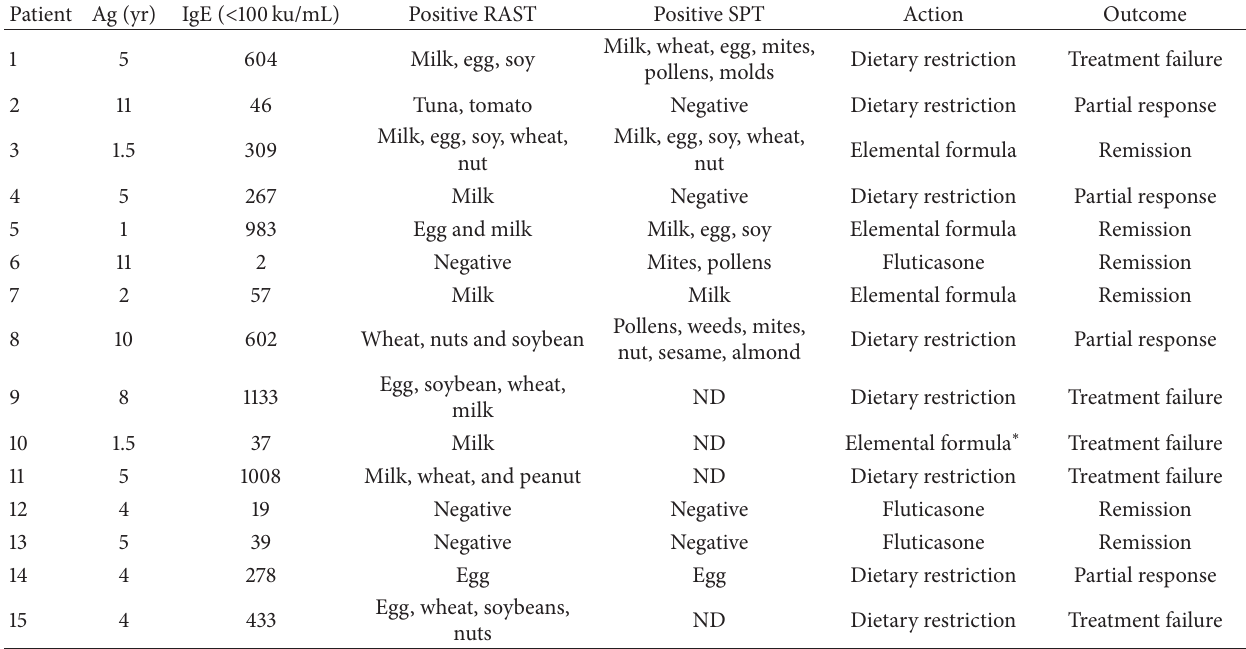
Table 4: Results of allergy testing and therapy in 15 children with eosinophilic esophagitis.